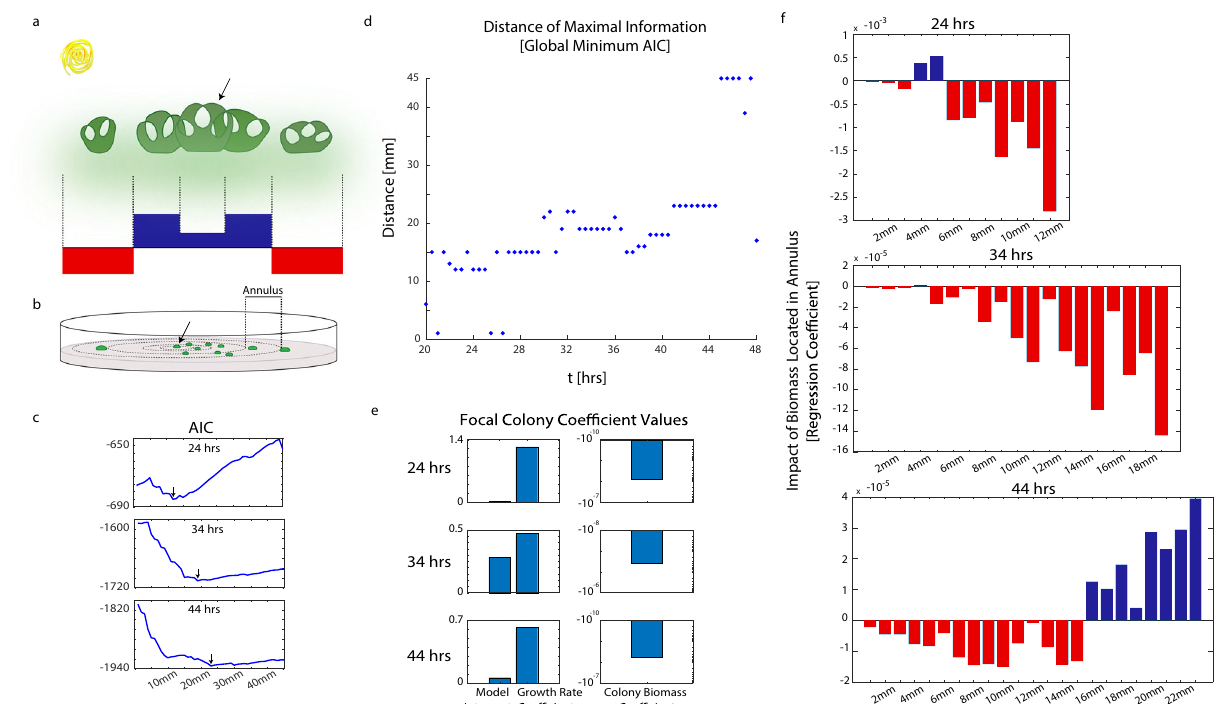
Fig. 3 The spatial-temporal environment of a colony as inferred by statistical model selection. a Cartoon describing spatial kernels as identi fi ed in arid ecological systems. The growth of a focal individual (black arrow) can be in fl uenced by its surrounding environment. b Cartoon depicting a spatial kernel framework in a microbial CFU experiment. Black arrow indicates focal colony. c Model selection results, quanti fi ed by the Akaike Information Criterion (AIC). Each point on the curve represents the AIC of a model created with data at the timepoint speci fi ed. The features in the model include colony-centric features (see e ) and all annuli proceeding outward from the focal colony up to and including the distance indicated along the x -axis. The minimum AIC is marked (black arrow). d Distance corresponding with the best regression model (global minimum AIC) at each timepoint. e Intercept and focal colony coef fi cient values fi tted independently at three timepoints. f Spatial-temporal kernel models. Each ecological kernel is fi tted independently at the designated